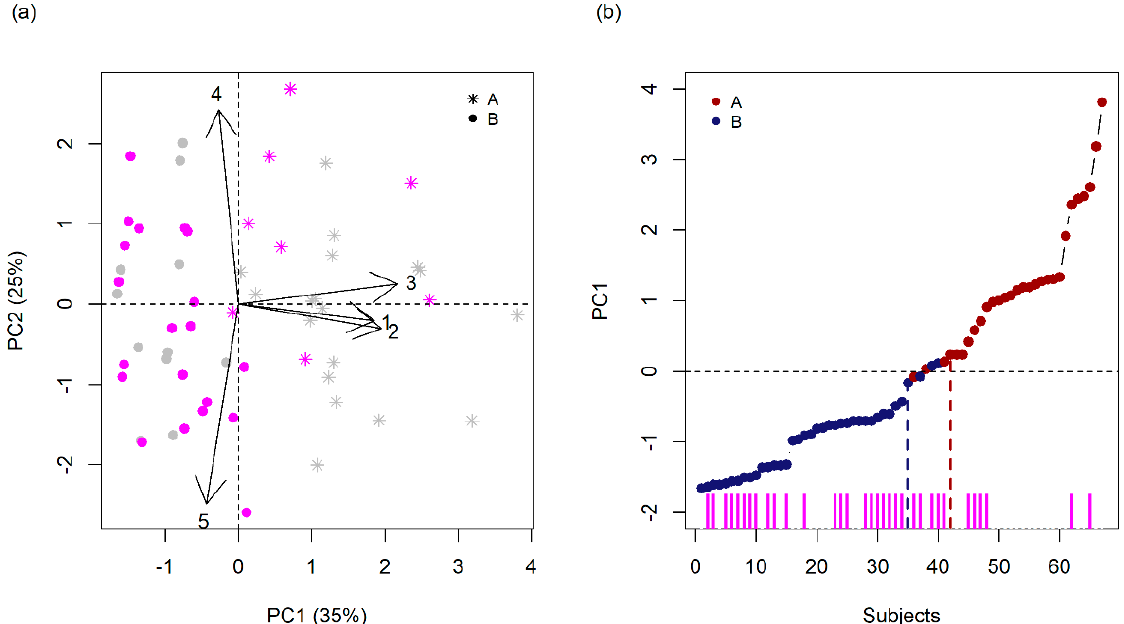
Figure 1. PCA identification of Psychosocial stress Vulnerability (PV) and Biological Vulnerability (BV) components. ( a ) PCA Biplot, corresponding percentage variances, and average PC1 and PC2 values (dashed lines). Original variables contributions are estimated by their eigenvectors (arrows): 1-Maternal Stress; 2-Maternal Schooling; 3-Social Class; 4-Gestational Complications; 5-Psychiatric Family History. Group A and B are represented by an asterisk and dot, respectively ( b ) Definition of above (A, red) and below (B, blue) PV average groups. Vertical lines mark A and B separation and a buffer zone in between. An arbitrary subsample had their exome examined (magenta in both panels). Whole-exome sequenced samples are represented in magenta.